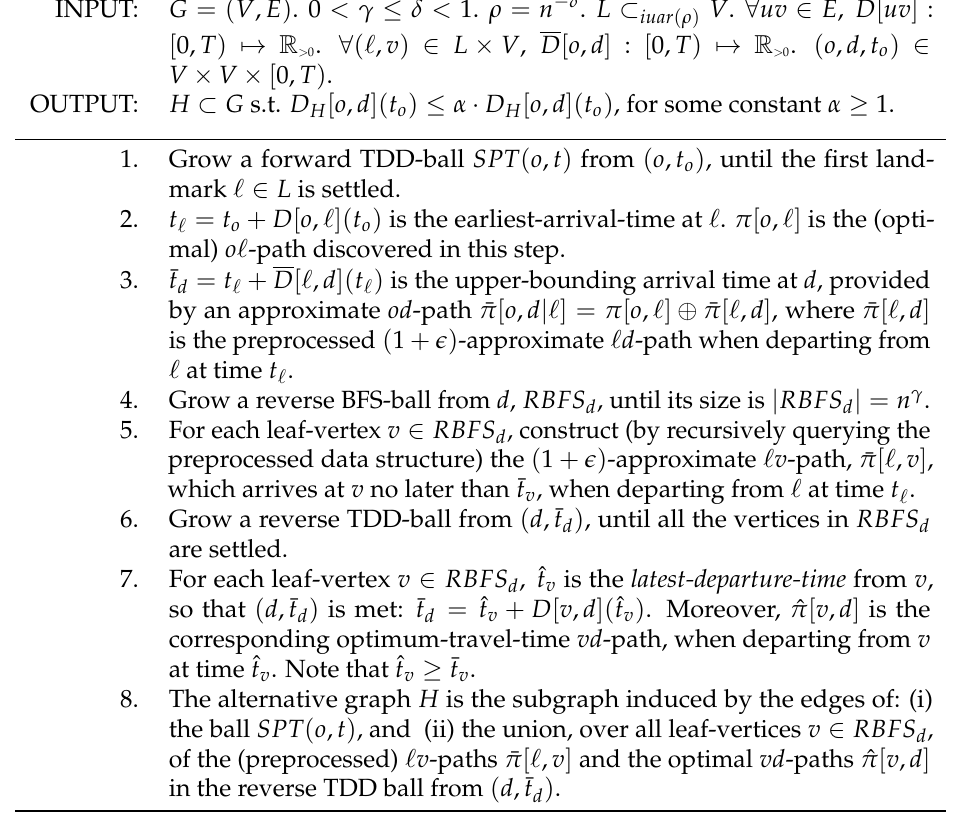
Figure 3. The pseudocode for